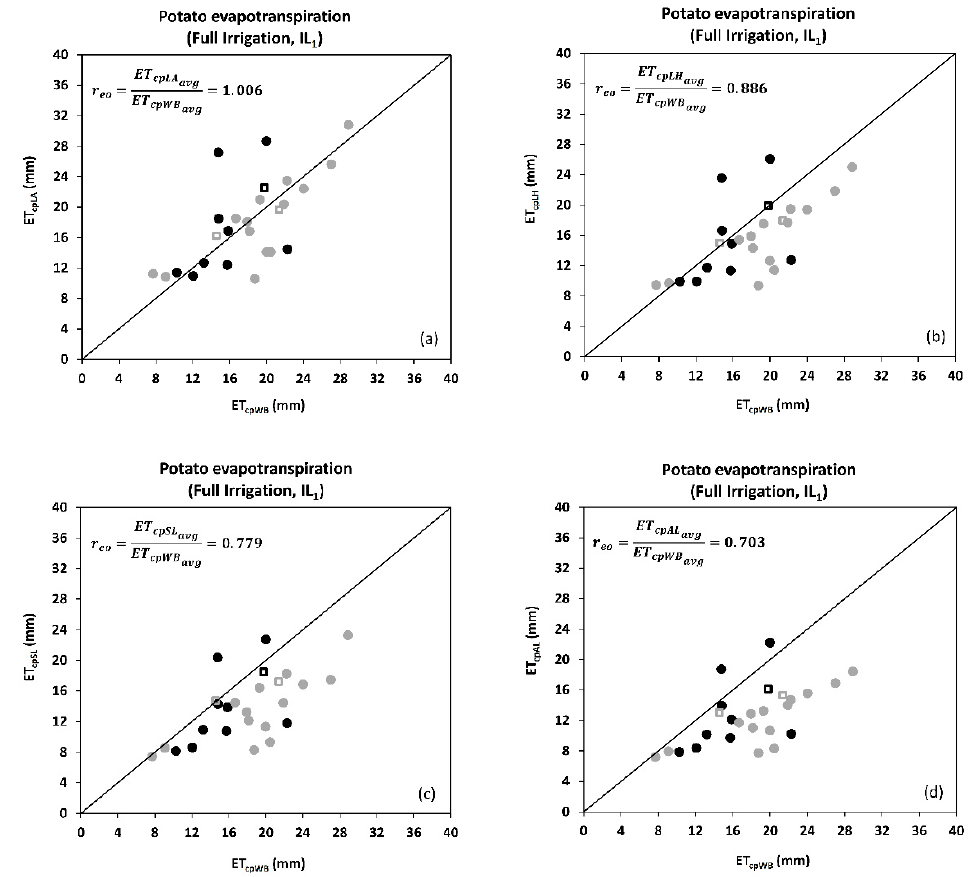
Figure 6. Comparison between potato evapotranspiration estimated by the water balance ( ET cpWP ) and Penman-Monteith ( ET cp ) methods using four canopy resistance approaches in full irrigation conditions (IL 1 ) for both seasons. LA and LH [63], SL [62] and AL [28] corresponding to the canopy resistance ( r c ) model at each ET cp approaches used in this study. ( a ), ( b ), ( c ), and ( d ) represent to LA, LH, SL, and AL, rspectively. Closed circles and open squares of black color correspond to the 2018/2019 season, whereas closed circles and open squares of gray color correspond to the 2019/2020 season. Square and circle points represent values of ET when LAI < 2 and LAI > 2, respectively. Each point compares the sum of ET among consecutive irrigation events.